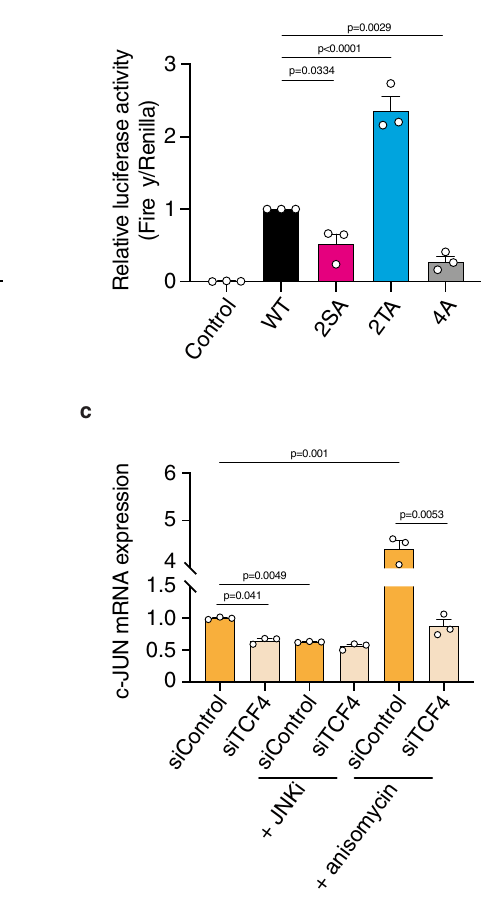
independent experiments).Non-signi fi cant terms are indicated as ‘ ns ’ . b , c Graphs showing the difference in c-JUN mRNAexpressionbetweencontrol, siMBD3 ( b ) or siTCF4 ( c ) transfected HCT116 human colorectal cancer cells. HCT116 cells were further treated with JNKi or anisomycin. Data are shown as the mean±standard error of the mean (SEM). Statistical signi fi cance was determined by One-way ANOVA with Tukey ’ s multiple comparisons test ( n =3 biologically independent experiments). Source data are provided as a Source Data fi